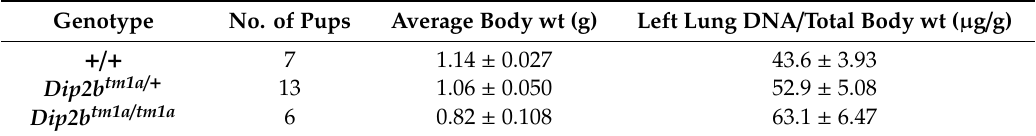
Table 2. Body weight and DNA contents of the left